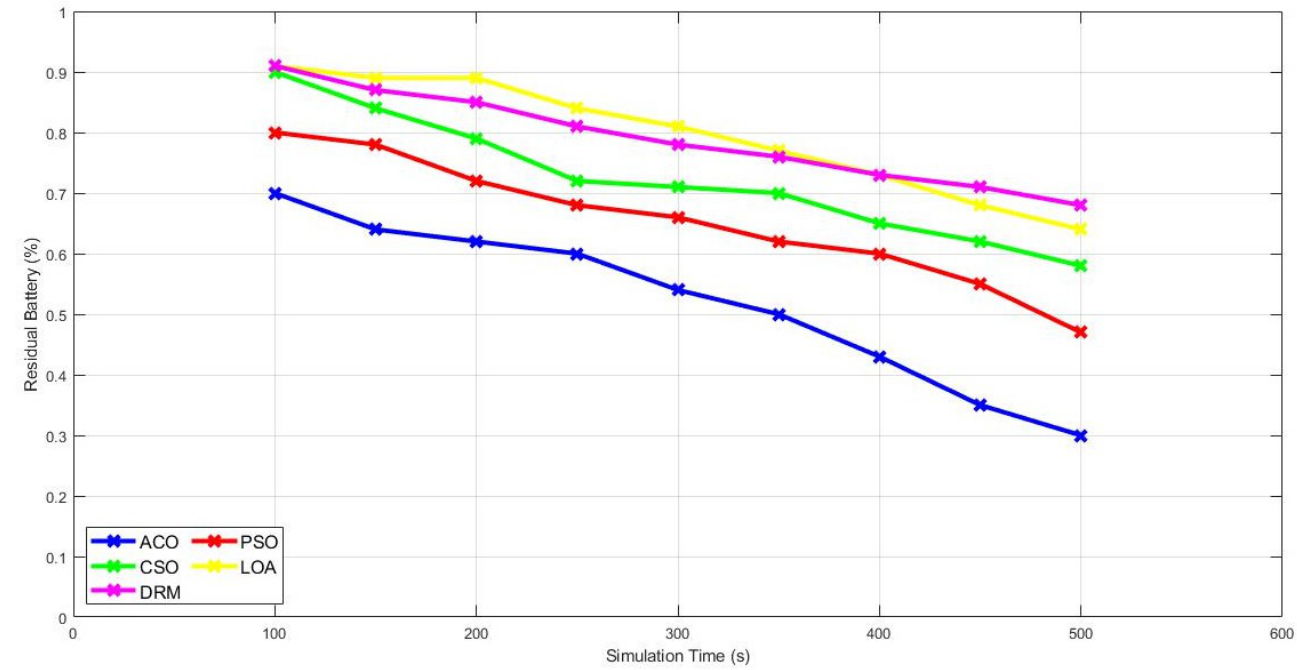
Figure 7. Average latency comparison for different network size.